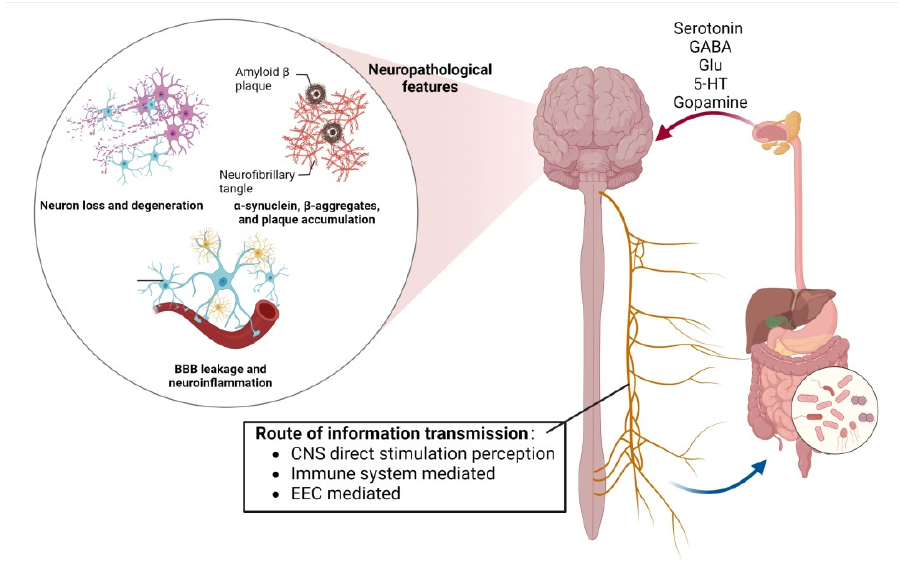
Figure 1. The bidirectional action between the gut–brain axis can be regulated by the blood–brain barrier, neurons and amyloid β -protein, affecting the emotional and cognitive parts of the